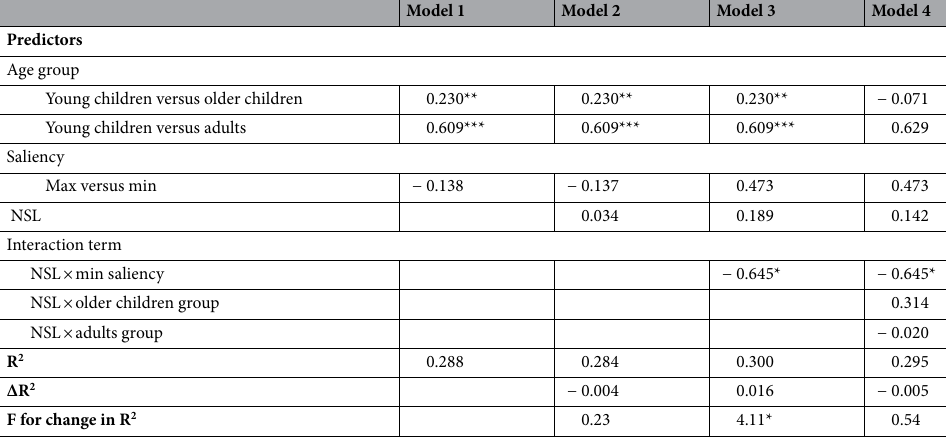
Table 2. Summary of hierarchical regression analyses for variables predicting the ‘Accuracy sensitivity’ index. Standardized regression coefficients (β) are reported for each predictor. The age group was presented as three dummy variables (young children, older children, and adults) with young children serving as the reference group. The saliency condition was presented as two dummy variables (Max and Min) with Max saliency serving as reference condition. * p < .05, ** p < .01, *** p < .001.